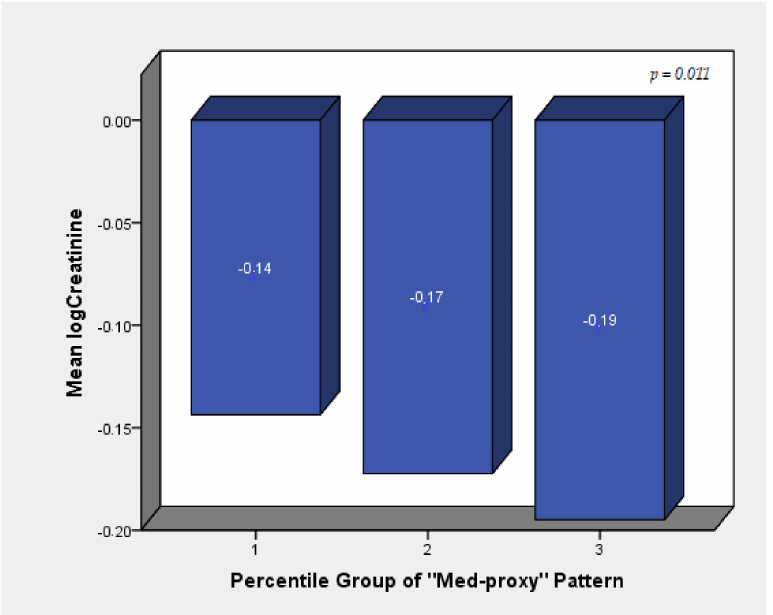
Figure 7. Percentile distribution and associations between the “Med-proxy” Pattern and logCreati- nine